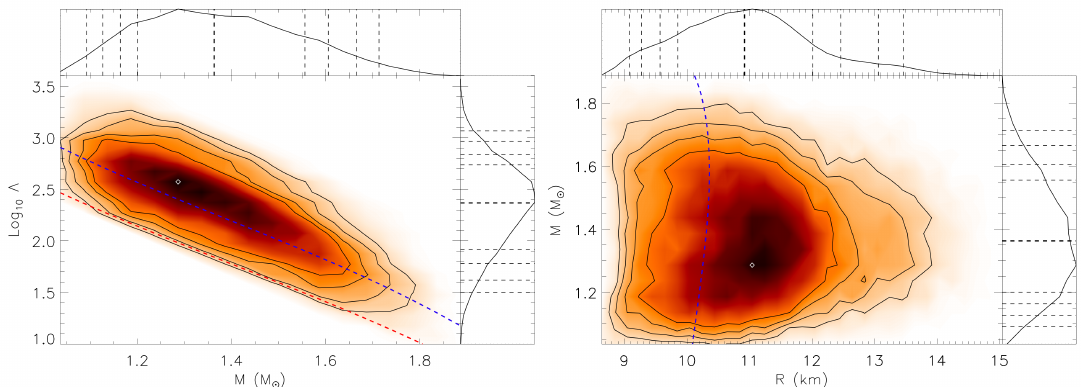
Figure 9. Similar to Figure 8 but for Λ ( M ) ( left panel ) and M ( R ) ( right panel , using Equation (21) to estimate radii from M and Λ .). Attached side panels show the integrated probability distributions over Λ , M or R . The red (blue) dashed curves show bounds from causality (the unitary gas conjecture ) [37]. The regions with M > ( < ) 1.365 M (cid:12) refer to the more (less) massive